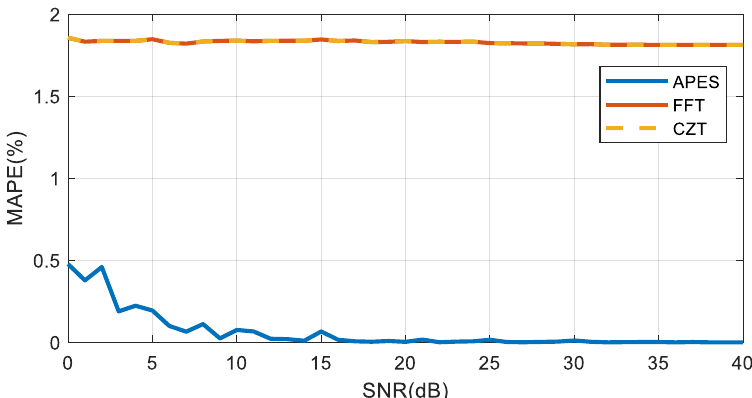
Figure 4. Mean absolute percentage error (MAPE) vs. different signal to noise ratio (SNR). The blue solid curve, the red solid curve, and the yellow dash curve are the results obtained by APES, FFT, and CZT, respectively.